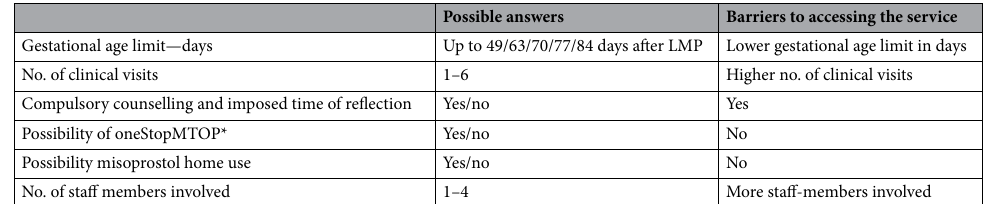
Table 1. Protocol characteristics, which may constitute barriers to accessing the service–definitions. *One Stop (one clinical visit) for Medical Termination of Pregnancy.